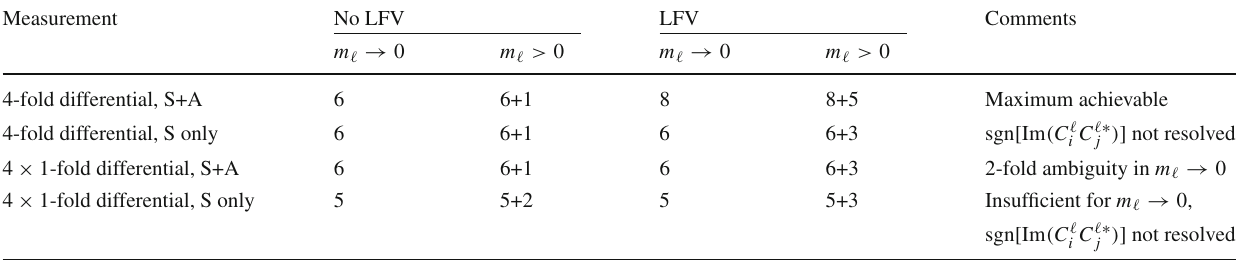
Table 2 Amount of BSM physics information that can be extracted in different scenarios, see also text. Here S and A denote the measurement of the CP average and the CP asymmetry of the respective differential rate. The first and second number corresponds to the number of parameters that can be extracted without and with mass suppression, respectively